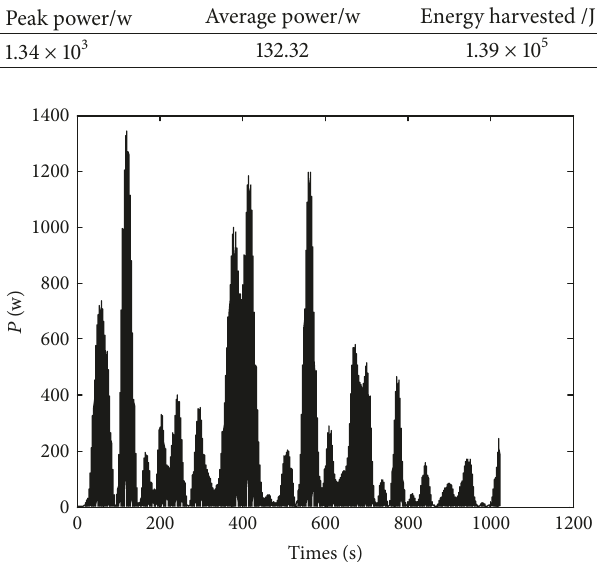
Figure 8: Time histories of the harvested power of ERS-TMDI.